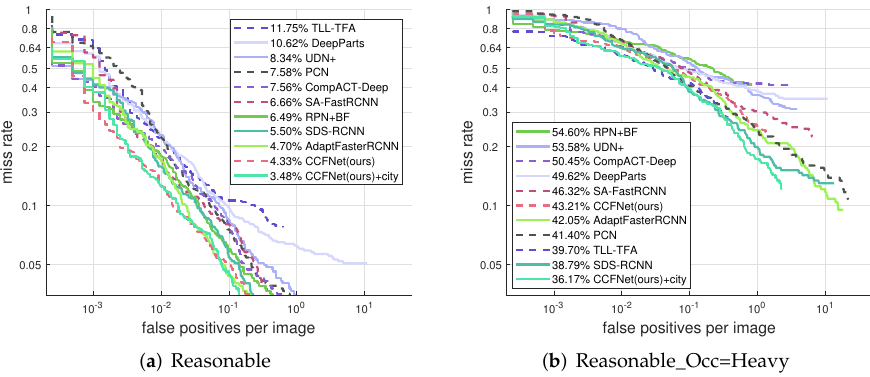
Figure 5. The results of various models on the Caltech dataset. ( a ) Compare with existing methods on Reasonable subset. ( b ) Compare with existing methods on the Reasonable_Occ=Heavy subset.